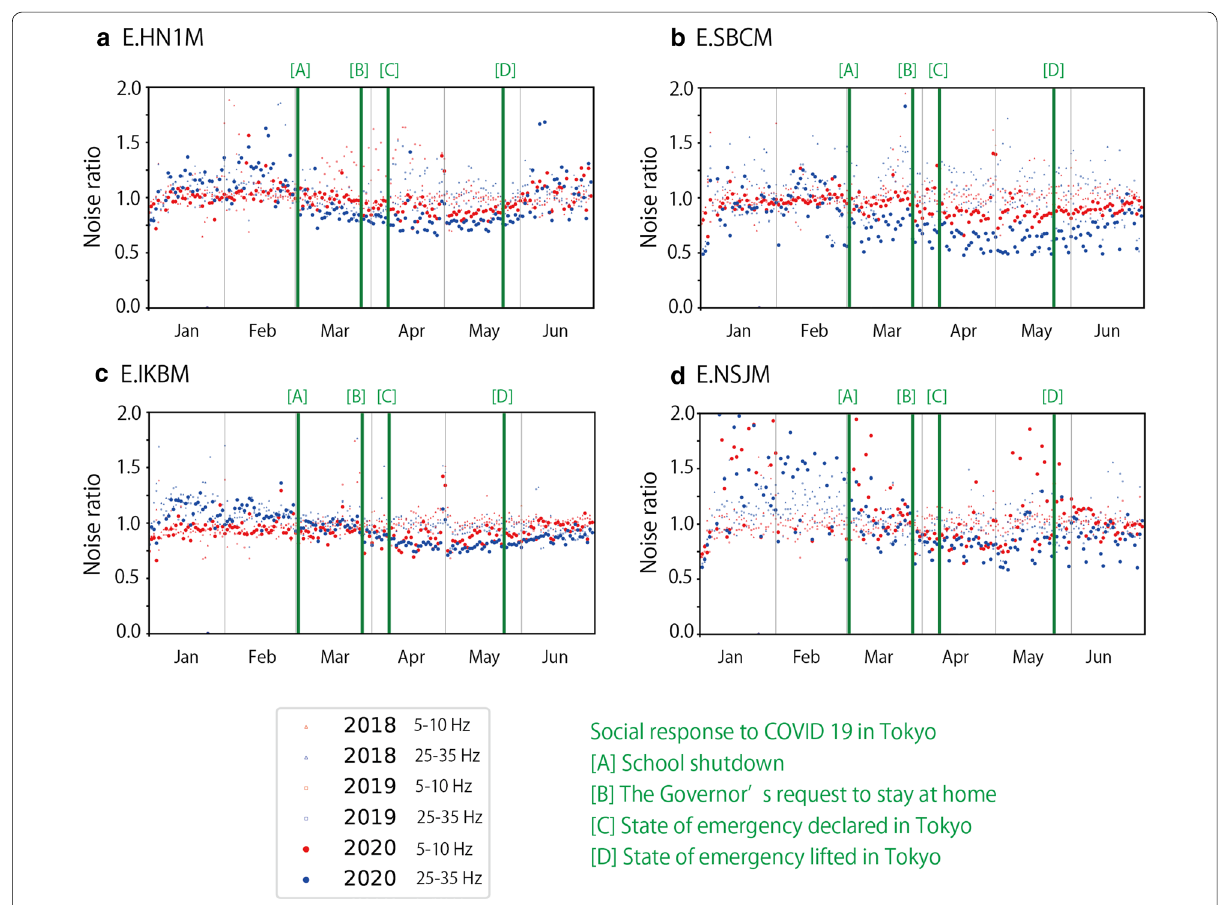
Fig. 8 Median noise ratio during the day in two different frequency bands at four